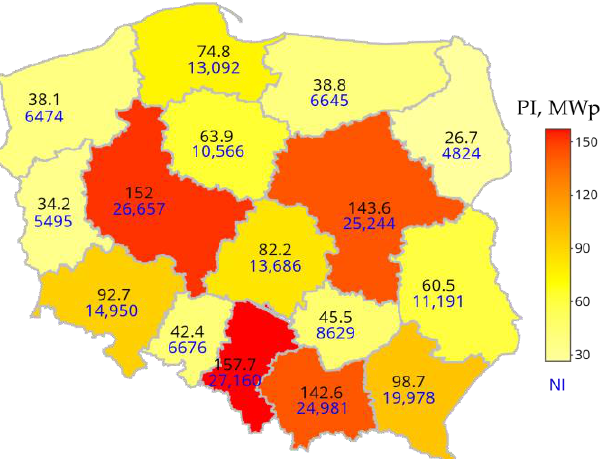
Figure 5. Total results of the 1st and 2nd rounds of the “My Electricity” recruitment carried out in 2019 and 2020: power of installations (PI); number of installations (NI).